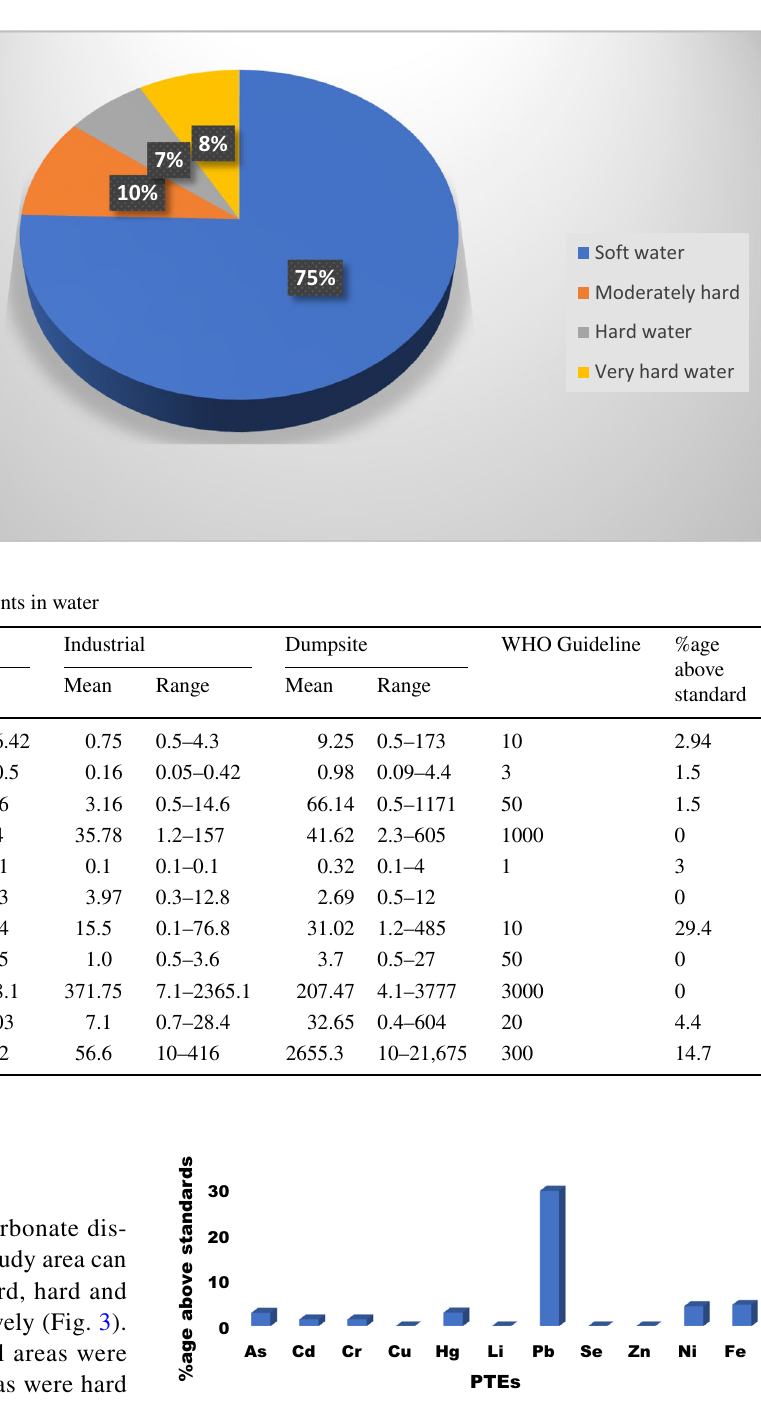
Fig. 4 Percentage of PTEs above WHO